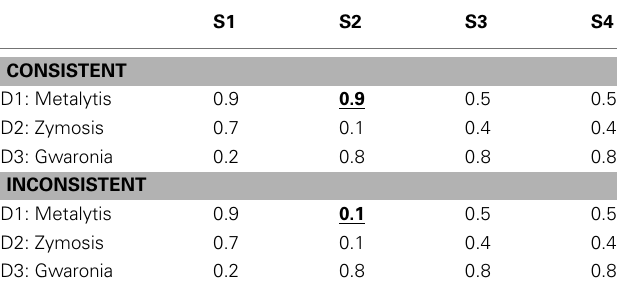
Table 3 | Disease × Symptom ecologies of Experiment 2.